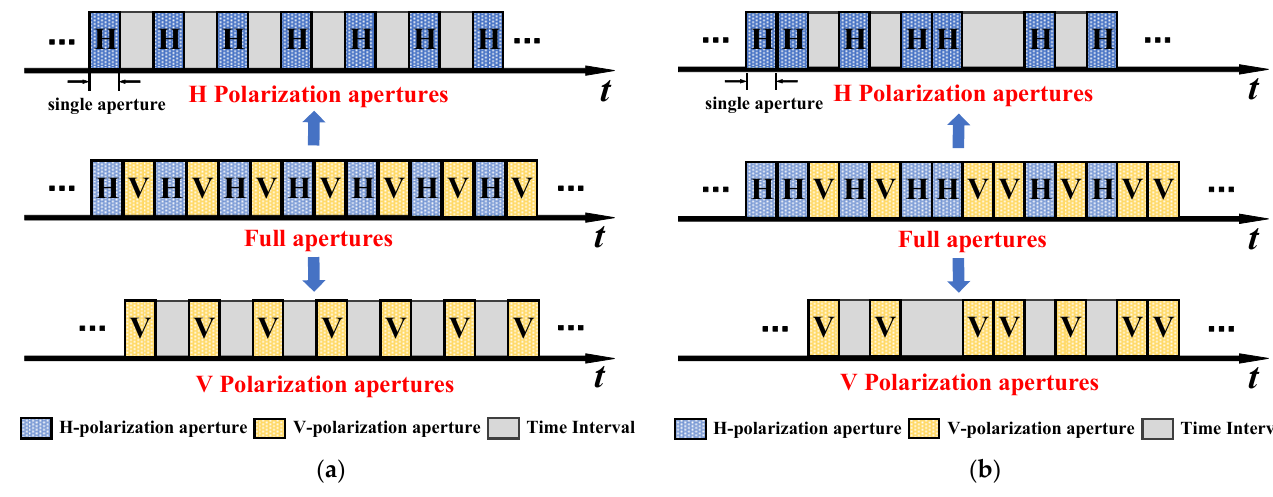
Figure 2. Two different aperture arrangements: ( a ) uniform alternating aperture; ( b ) orthogonal coding apertures.